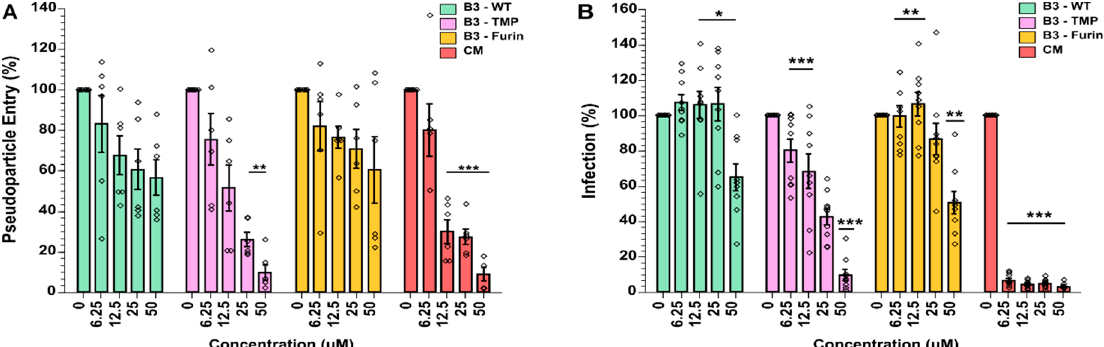
Figure 4. SerpinB3 variants inhibited cell entry of lentiviral S-pseudoparticles and SARS-CoV-2 infection and replication. ( A ) A549-ACE2-TMPRSS2 cells were incubated for 1 h with media (control) or with increasing concentrations of SerpinB3 variants or CM, followed by infection with SARS-CoV-2 S pseudoparticles (in 1:1 ratio). Luciferase activities (representing pseudoparticle entry) were analysed in cell lysates at 48 h post-pseudoparticle infection. ( B ) VeroE6/TMPRSS2 cells were treated with increasing concentrations of SerpinB3 variants 1 h before, simultaneously with, and 18 h post- infection with SARS-CoV-2, with the percentage of SARS-CoV-2 infected cells determined using flow cytometry to detect virus nucleocapsid staining. The mean ± SEM from n = 2 ( A ) or n = 3 ( B ) independent experiments performed in triplicates. Two-way ANOVA with Tukey’s comparison test: * p < 0.05, ** p < 0.002, *** p < 0.0005. CM, Camostat Mesylate.